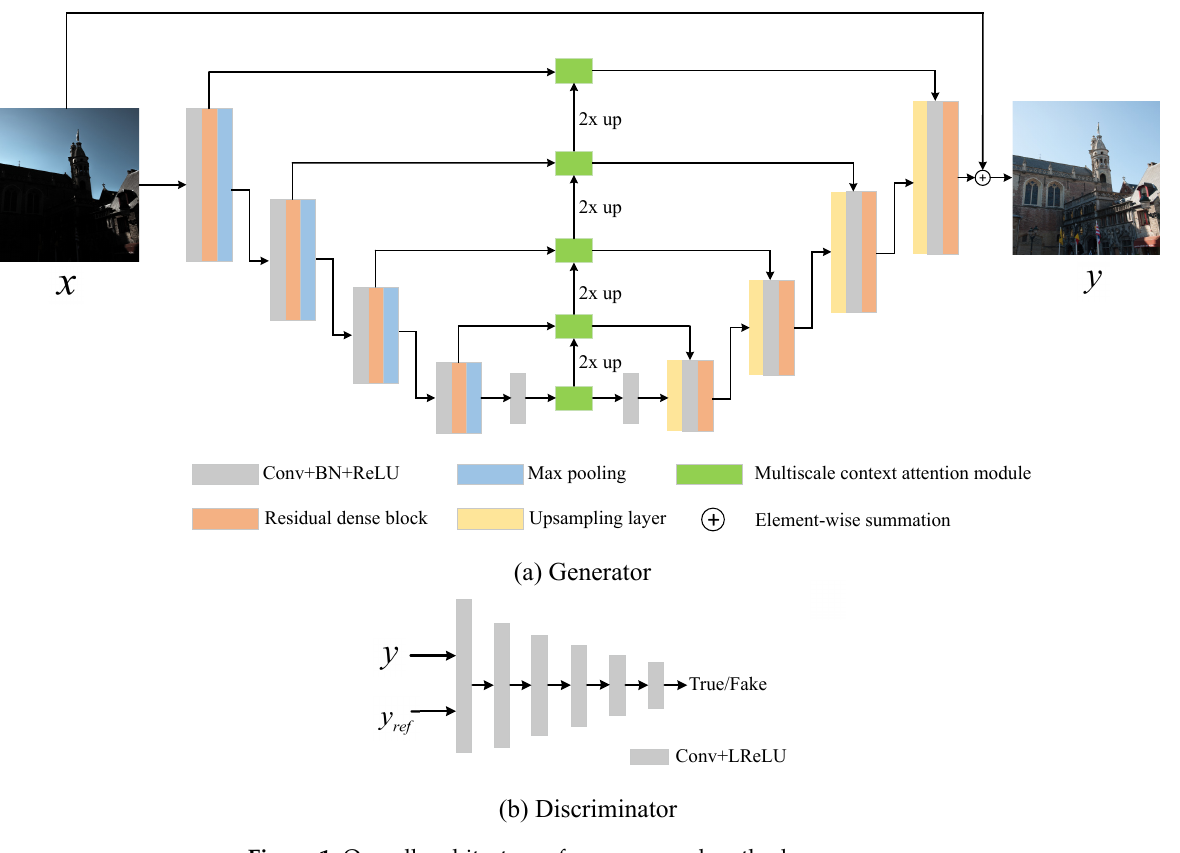
Figure 1. Overall architecture of our proposed